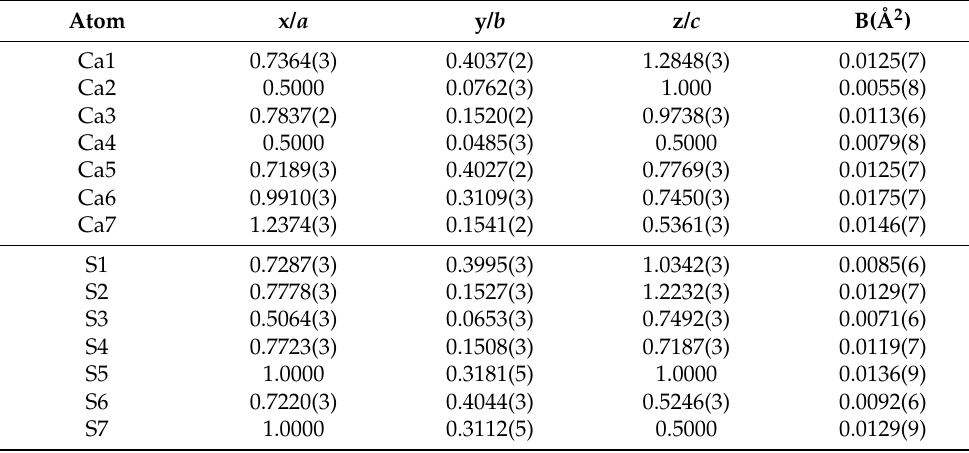
Table 4. Coordinates of CaSO 4 · 0.5H 2 O from the single-crystal diffraction